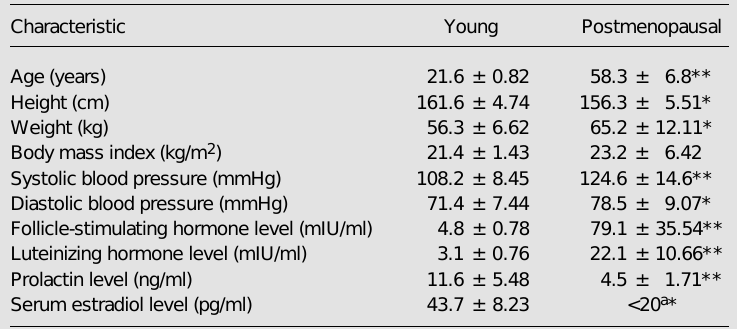
Table 1. Anthropometric, clinical and hormonal characteristics of the groups studied. Characteristic